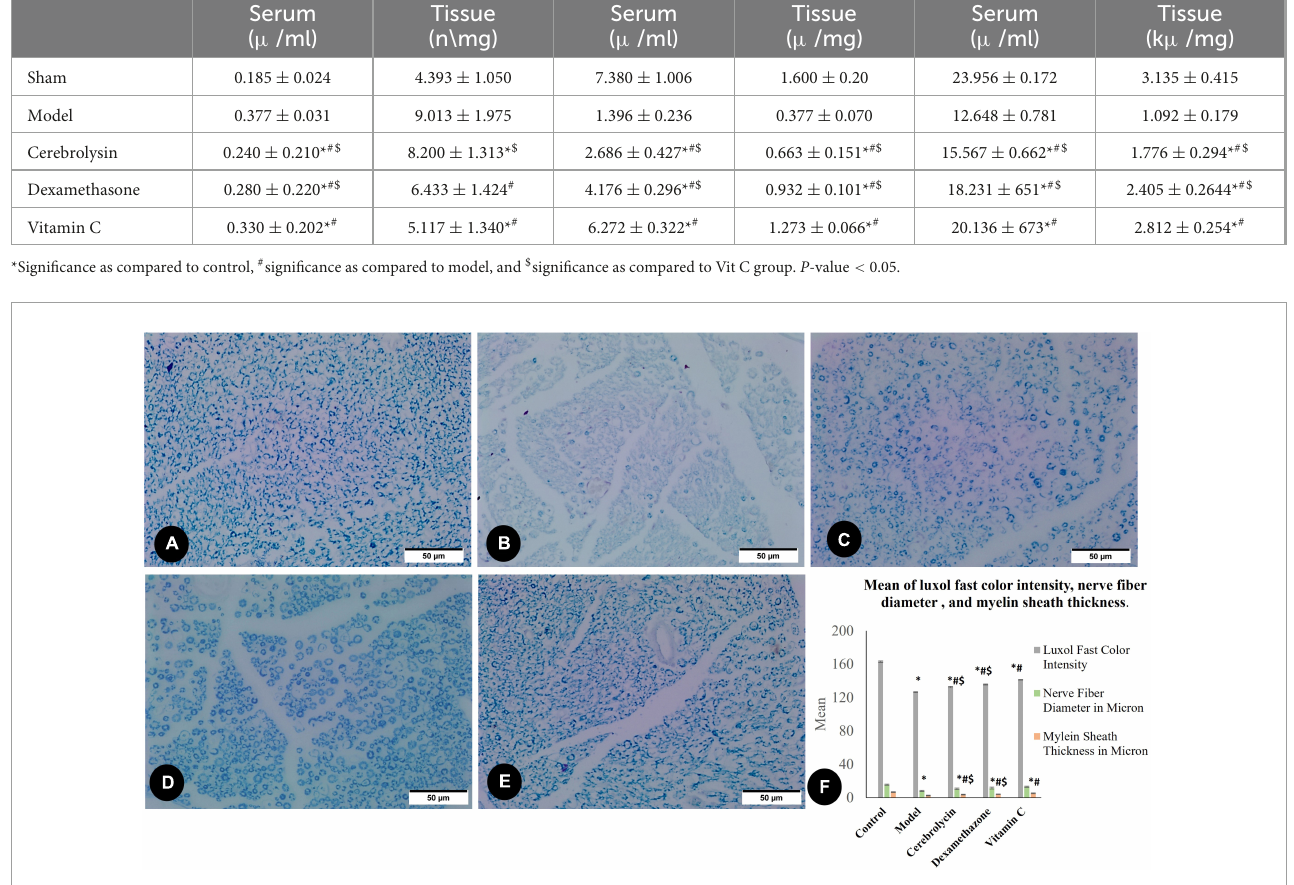
expression as compared to Cerebrolysin and dexamethasone-treated